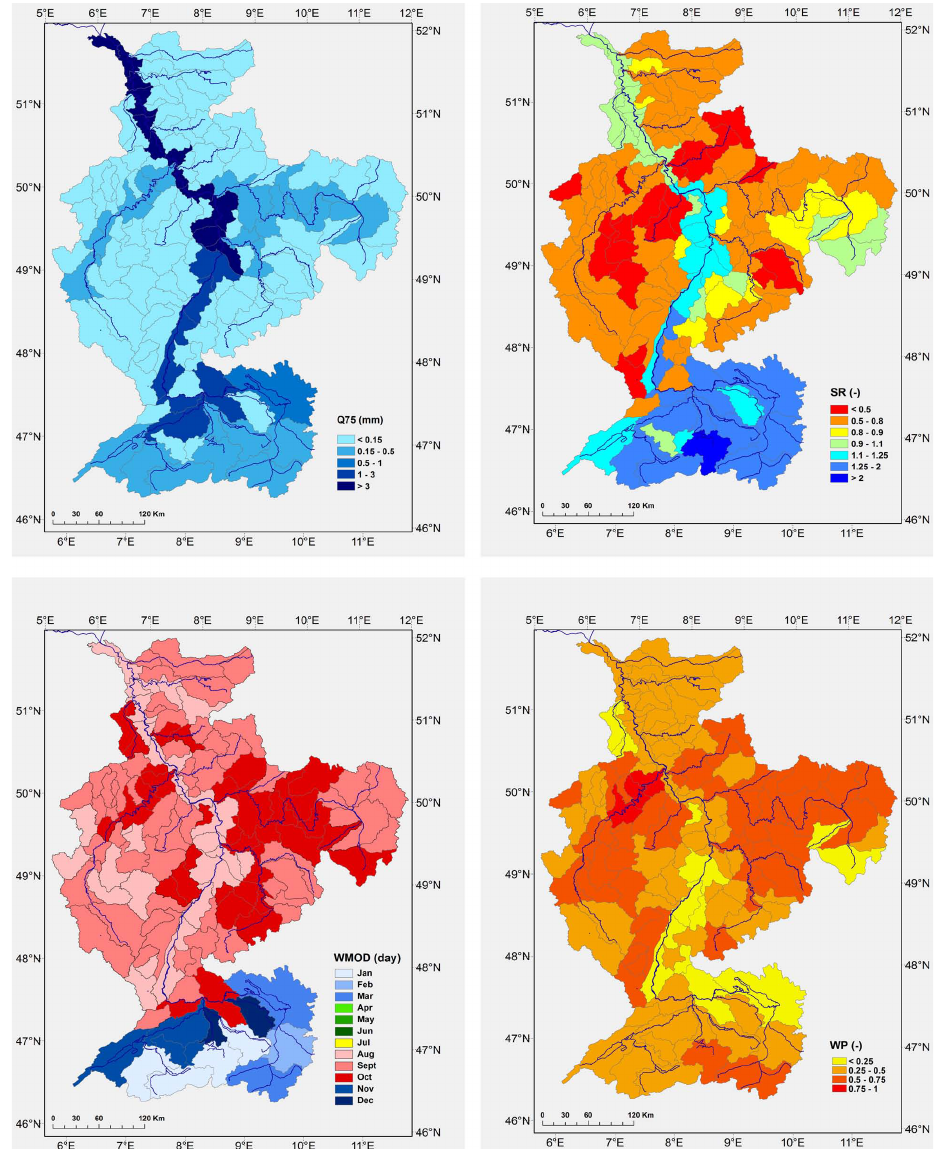
Fig. 3. Low flow threshold ( Q 75 in mmday − 1 and three seasonality indices (SR, WMOD and WP) estimated from simulated low flows using observed climate as model input in 134 sub-catchments for the period 1964–2007 (case 2).